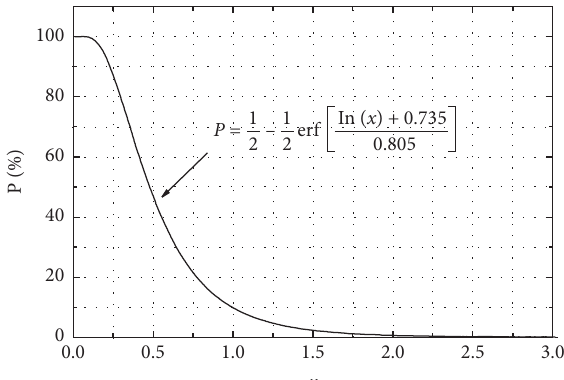
Figure 2: Transcendental probability function curves.